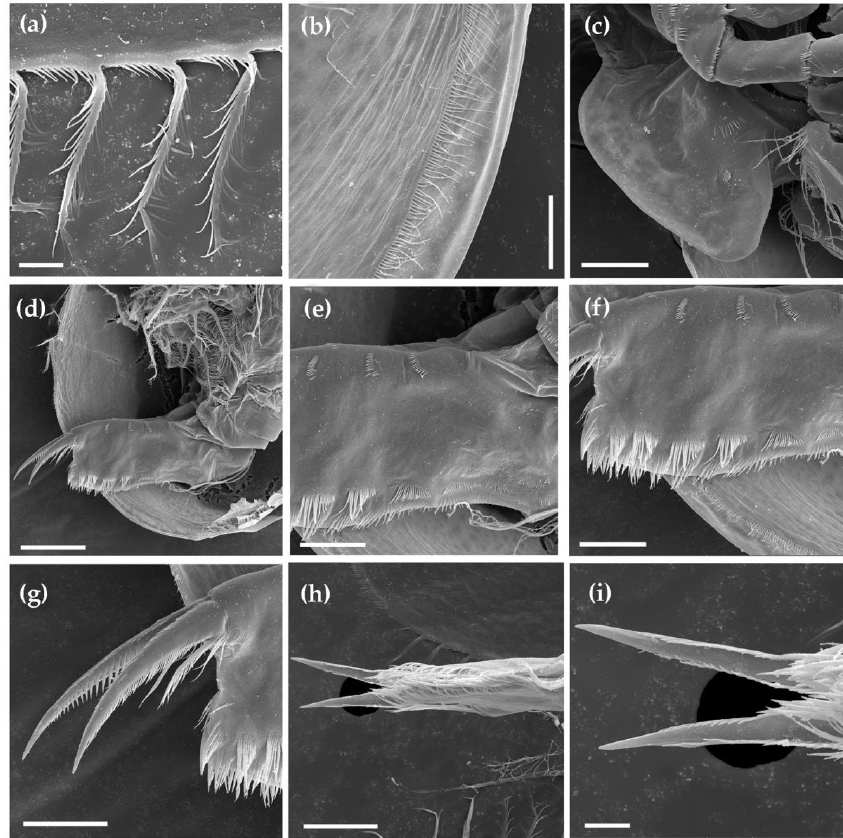
Figure 19. Coronatella anemae , an adult parthenogenetic female from Wadi Maidaq — Blue Pool, United Arab Emirates. ( a ) Armature of ventral margin of valve, inner view; ( b ) armature of posterior margin of valve, inner view; ( c ) labrum; ( d ) postabdomen; ( e , f ) armature of postabdomen with higher magnification; ( g ) postabdominal claws, lateral view; ( h , i ) postabdominal claws, dorsal view. Scale bars: 0.05 mm for ( d ), 0.02 mm for ( c , e – h ), 0.01 mm for ( b ), 0.005 mm for ( a , i ).